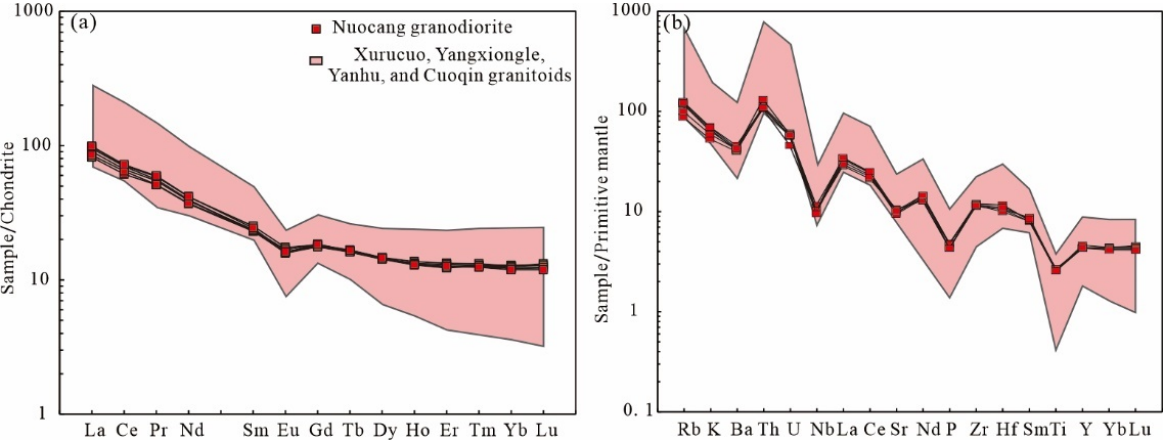
Figure 6. Chondrite normalized REE distribution diagram ( a ) and primitive mantle normalized trace element spider diagram ( b ) [46] for Nuocang granodiorites. Data are from the same source as Figure 5.